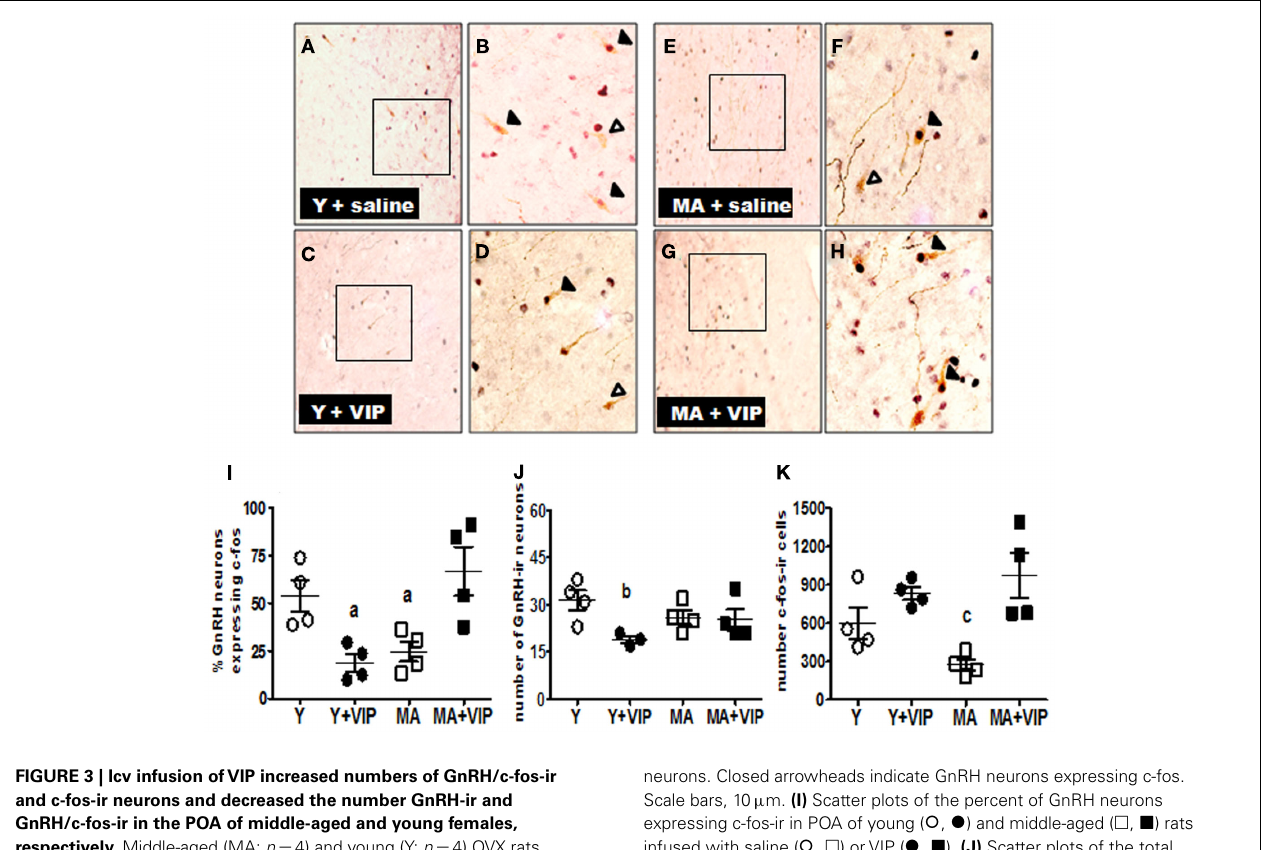
FIGURE 3 | Icv infusion ofVIP increased numbers of GnRH/c-fos-ir and c-fos-ir neurons and decreased the number GnRH-ir and GnRH/c-fos-ir in the POA of middle-aged and young females, respectively. Middle-aged (MA; n = 4) and young (Y; n = 4) OVX rats primed with E (2 μ g) and one injection of P (500 μ g) on the day of serum collection were infused icv with saline (control) orVIP (6nmol) between 1300 and 1600h and then perfused between 1600 and 1730h. Data are presented as mean ± SEM. Representative sections of double-label immunohistochemistry (20 × and 40 × magnification) showing GnRH neurons (brown cytoplasm) with c-fos-ir nuclei (black) in rats infused with saline (A,B,E,F) orVIP (C,D,G,H) . Open arrowhead indicate GnRH